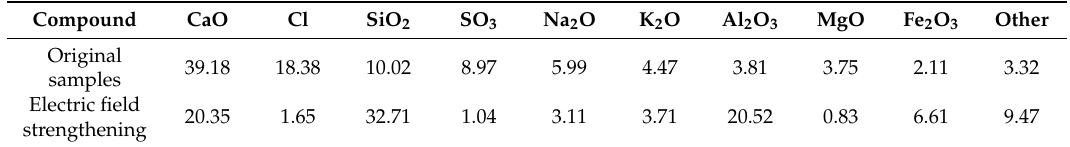
Table 4. Chemical composition of samples by XRF (wt.%).